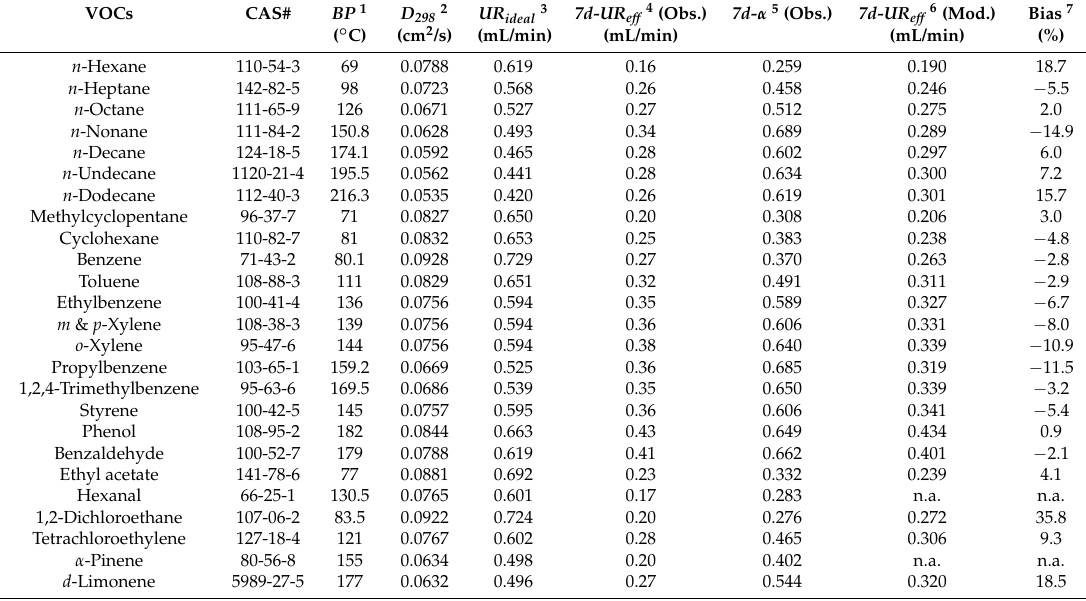
Table A2. Data used to model 7-day effective uptake rates.